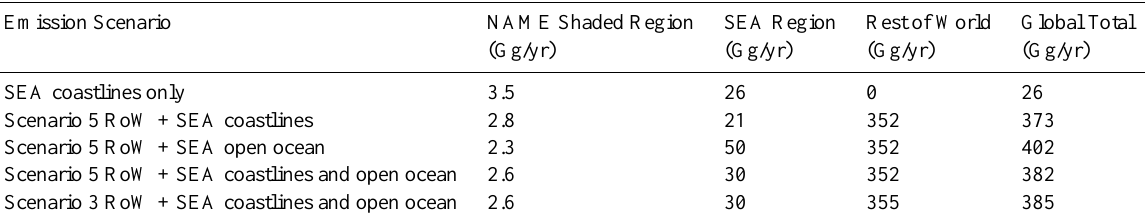
Fig. 7. Time series of regional tracer concentration for the lowest 100m of 0.2 ◦ squares (see Fig. 5 inset) centred on Danum (blue) and Kunak (red). To the top left of each plot is the mean regional tracer contribution to Danum (blue) and Kunak (red). To the top right is the regional rate of emission (in Gg CHBr 3 /yr). Due to their small impact we do not show the contributions from regions 1, 2, 8, 11 and 12. In total, the 5 excluded regions emit 0.3Gg CHBr 3 /yr ( ∼ 25% of the mass emitted from all regions combined) and supply ∼ 5% of the total tracer concentration at both sites. Table 1. Emission magnitudes required to provide matches between p-TOMCAT modelled bromoform and measurements of bromoform at the Danum Valley site in northern Borneo. Different geographical distributions of emissions within the SEA region require different emission magnitudes to reproduce the data. The fourth scenario (Scenario 5 RoW + SEA coastlines and open ocean, totalling 382Gg CHBr 3 /yr) is discussed further in the text as the “best